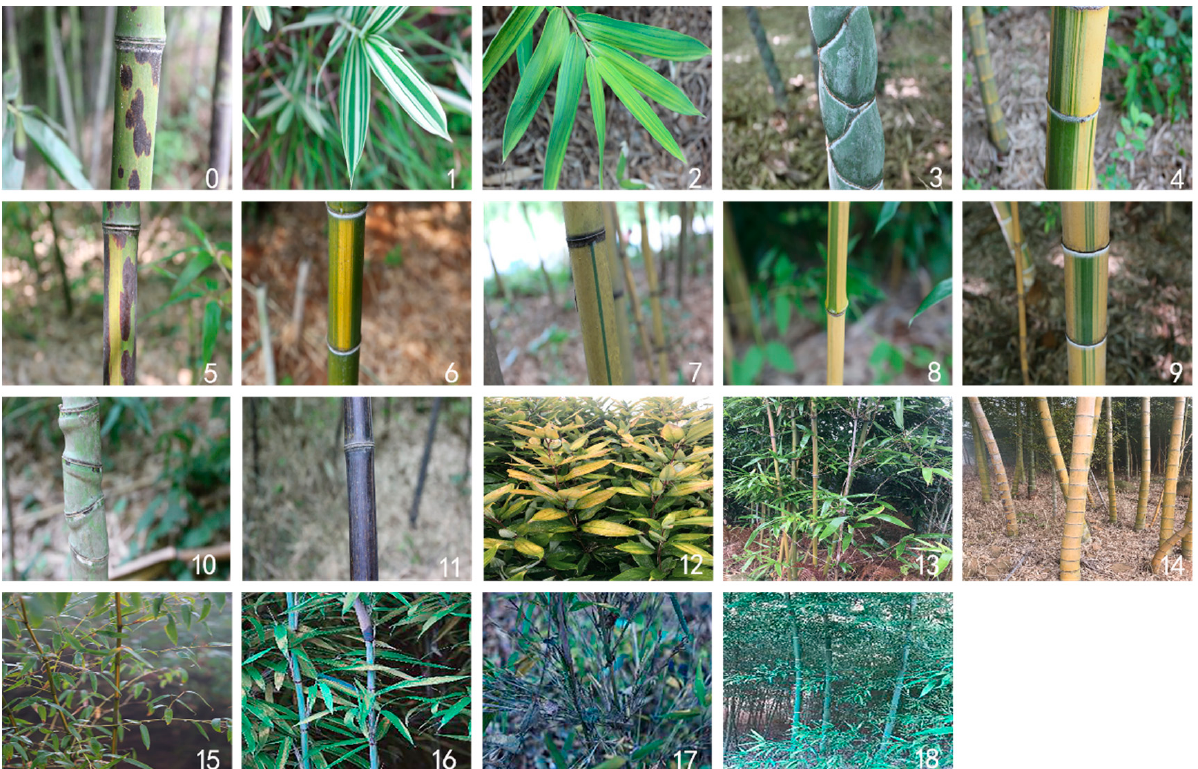
Figure 1. Nineteen species of bamboo sample [1,24]. Note: Nos. 0 – 4 are Phyllostachys bam- busoides Sieb. et Zucc. f. lacrima-deae Keng f. et Wen, Pleioblastus fortunei (v. Houtte) Nakai,